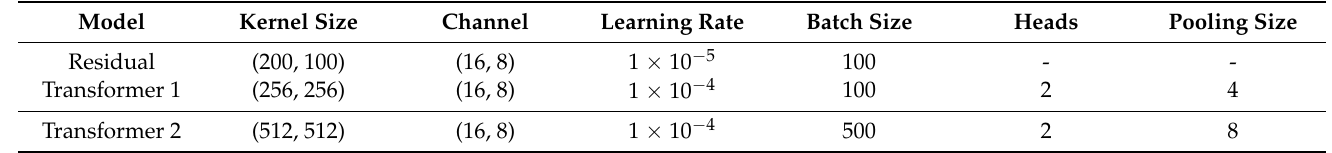
Table 2. Parameter configurations for network models.